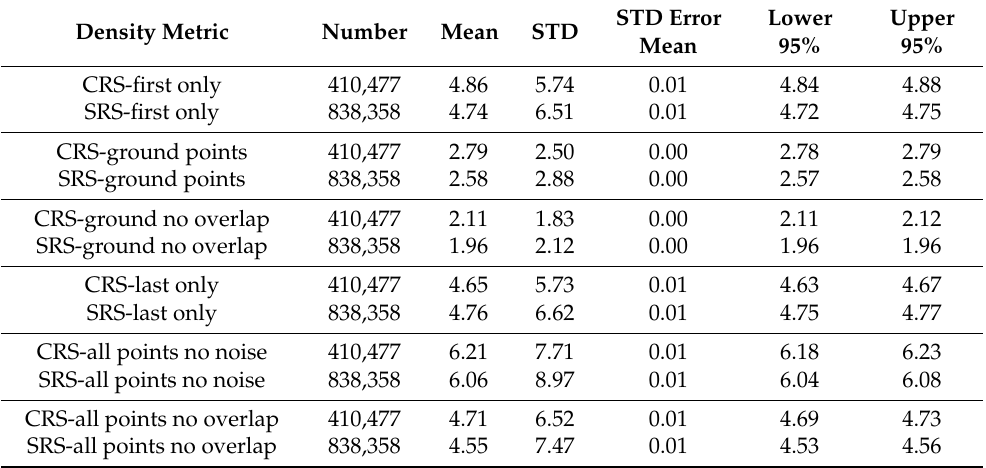
Table 16. Comparison of SRS and CRS estimates of point density. STD = standard